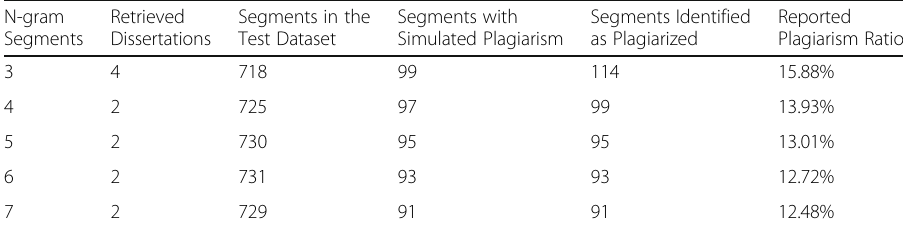
Table 15 Results of the paragraph simulated-plagiarism experiment N-gram